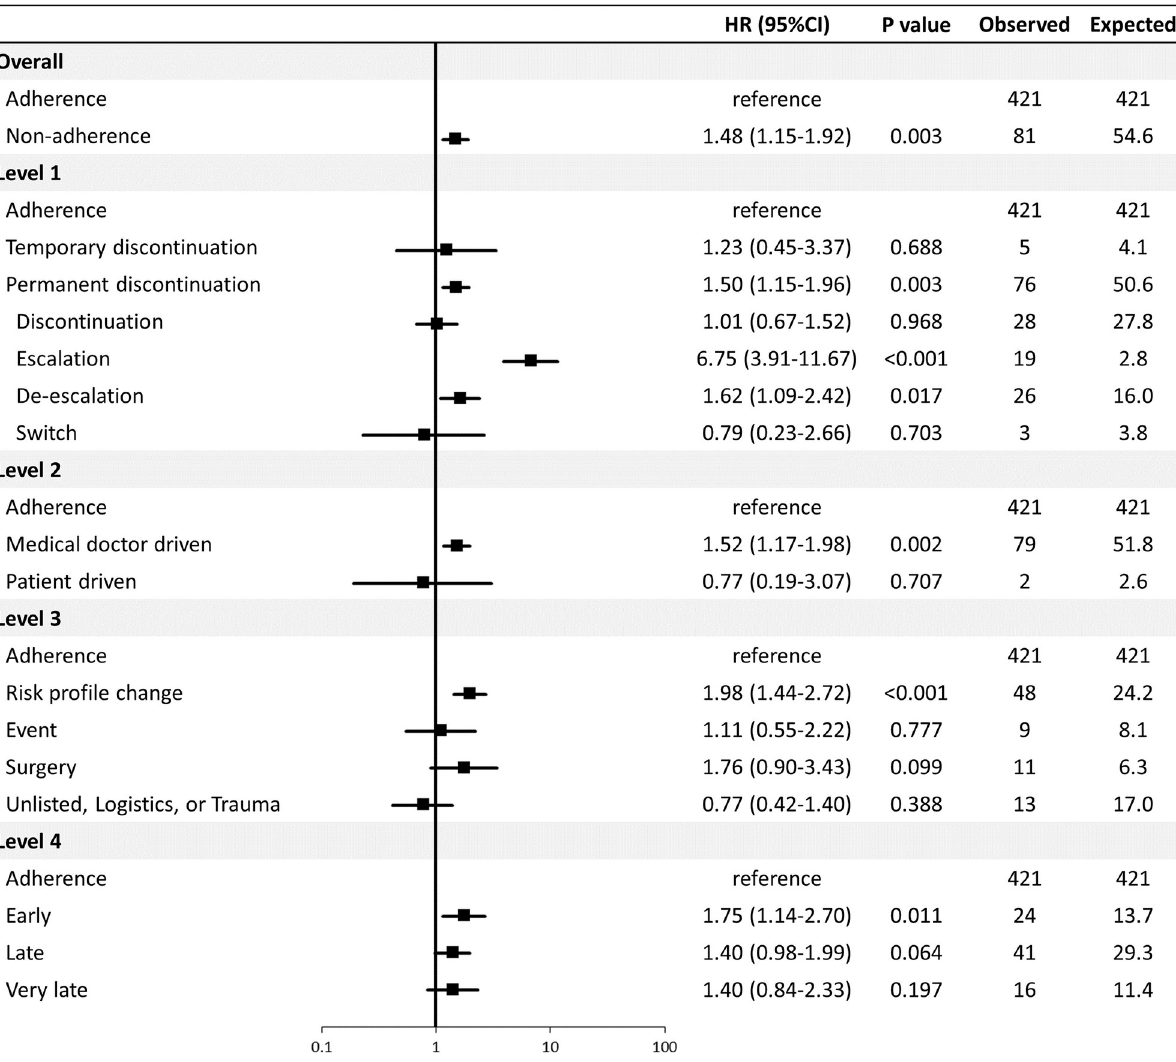
compared with an expected 54.6 events (81 events / HR 1.48) if a patient’s risk had been the same as adherence, which corresponds to an excess of 26.4 events (i.e. absolute attributable